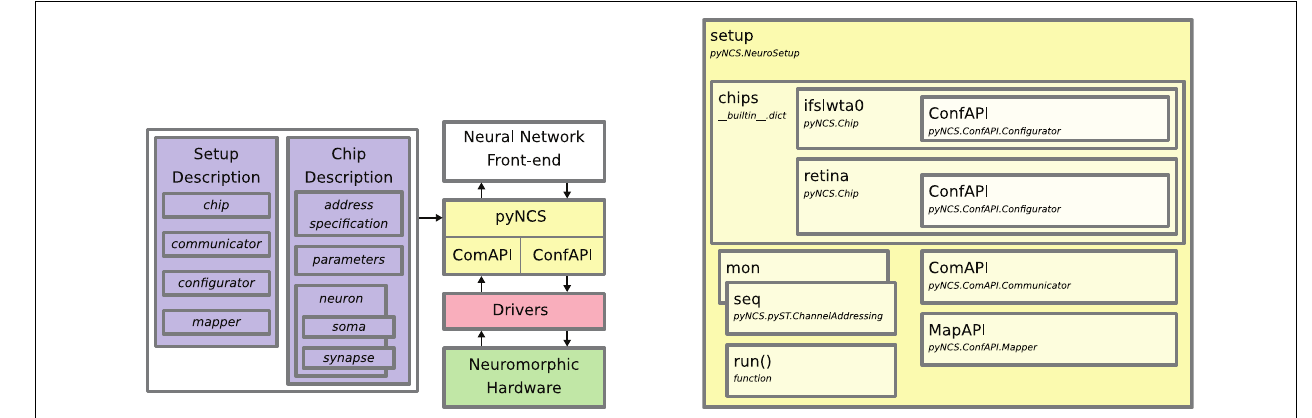
object serves as the gateway for performing all the operations involving the hardware. It contains the objects necessary for accessing the chips’ biases and parameters (in this example, two chips ifslwta0 and retina ), the objects that translate raw AER addresses into human readable ones ( mon , for monitoring events and seq for sequencing them) and the API modules for configuring the network topology ( pyNCS.ConfAPI.Mapper ) and for mediating the spike-event communication ( pyNCS.ComAPI. Communicator ). Examples of hardware specification XML files are provided in the supplementary